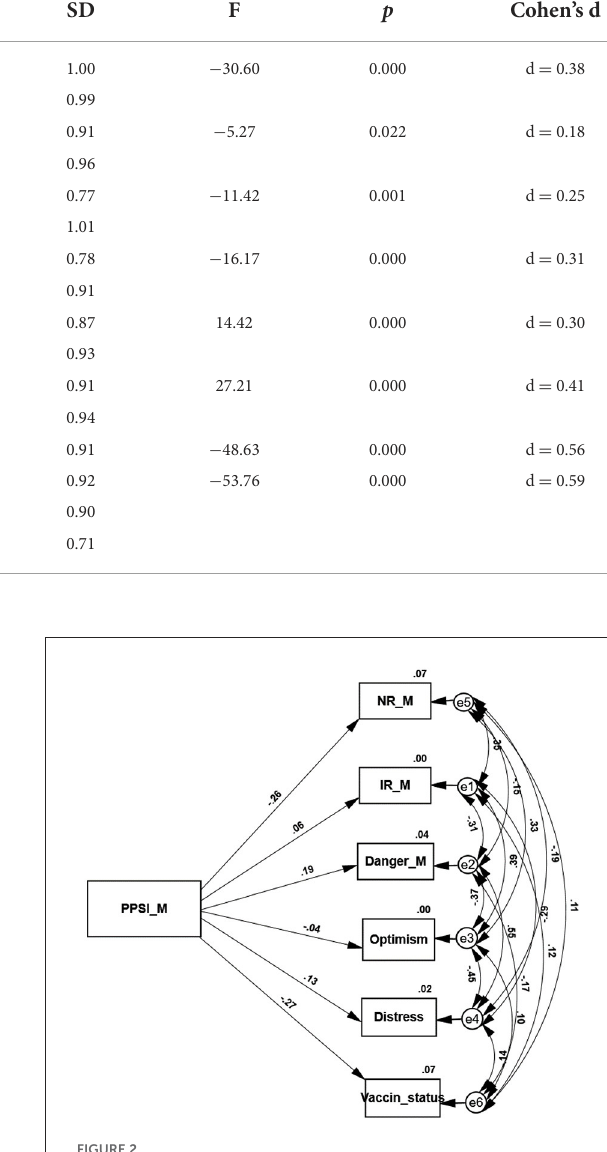
FIGURE1 A path analysis of the variables predicted by the PPSI score of the Jewish sample.